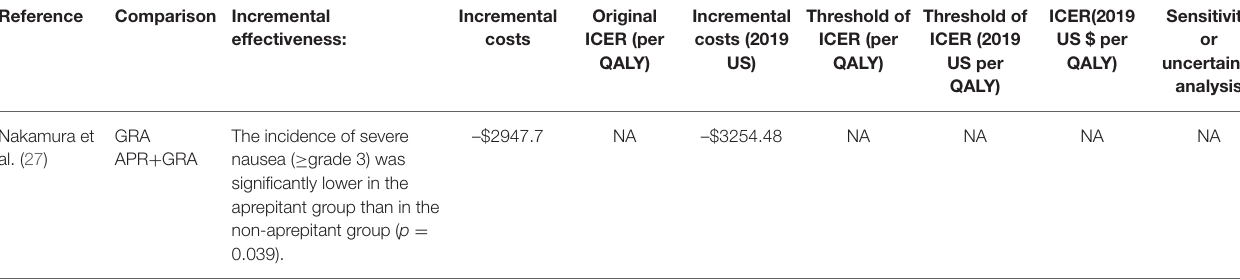
TABLE 5 | Summary of economic evaluation outcomes comparing aprepitant plus 5-HT3RA Vs. 5-HT3RA.